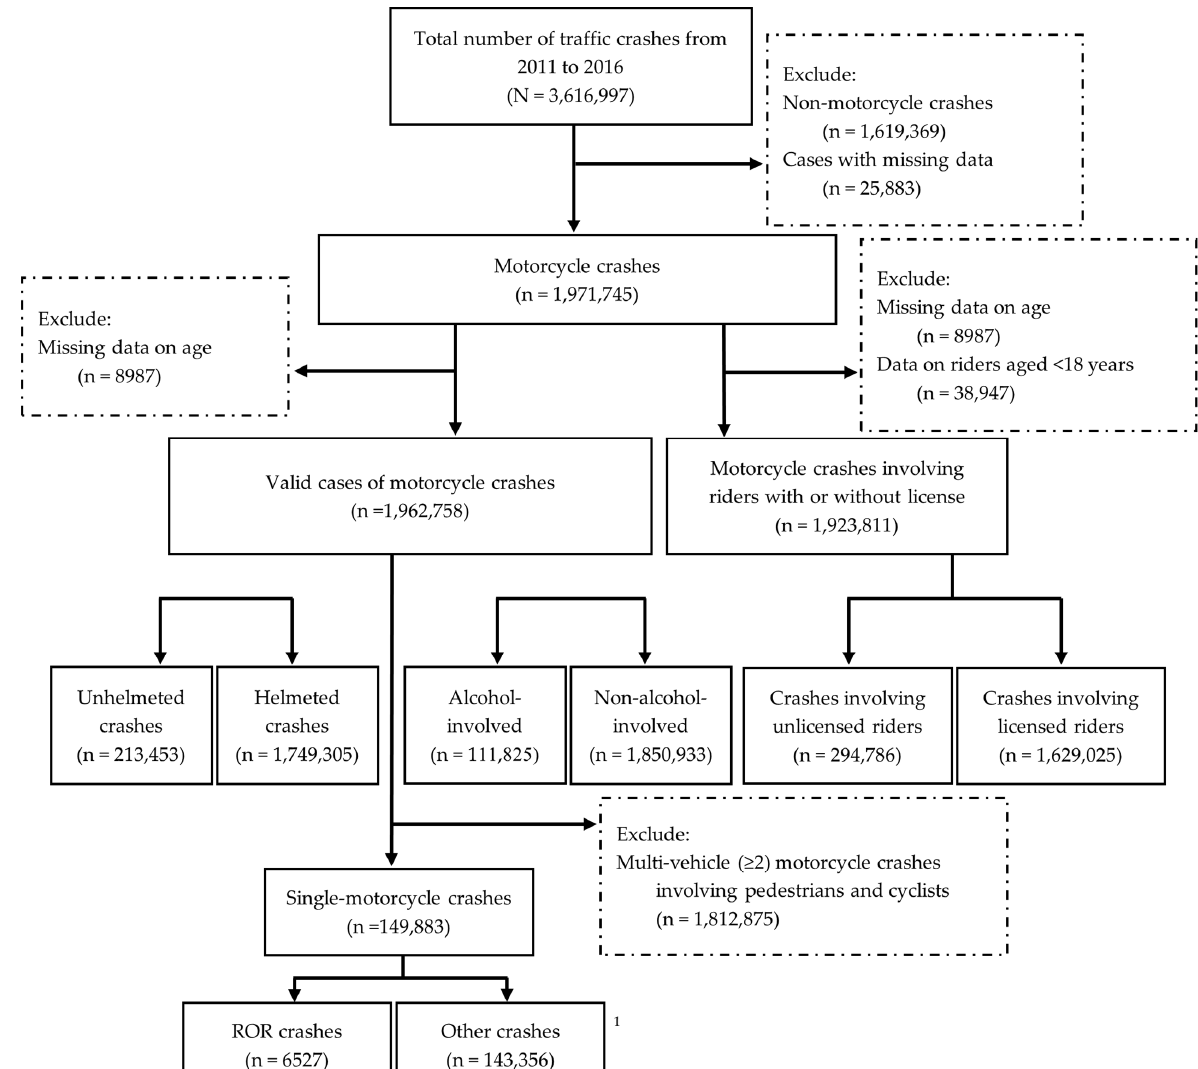
Figure 1. Sample selection process. 1 Other single ‐ motorcycle crashes involve: spillover crashes, hit other objects crashes, and hit traffic facilities crashes.